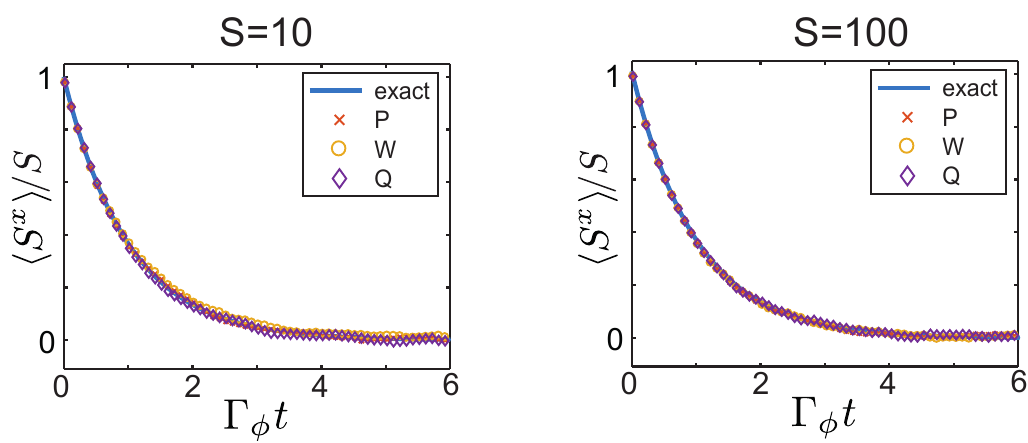
Figure 2: Dephasing of a collective spin as described by Eq. (24). For this plot, it is assumed that the system is initially prepared in a spin coherent state pointing along the x -direction, | S x = S 〉 , and the successive evolution of 〈 S x 〉 ( t ) is shown as a function of time. For this example the other two spin components vanish up to statistical errors. The exact results obtained from the full master equation are compared with stochastic simulations of Eq. (27) and Eq. (28) for k = 0, ± 1. To = 1000 trajectories were obtain this data n traj